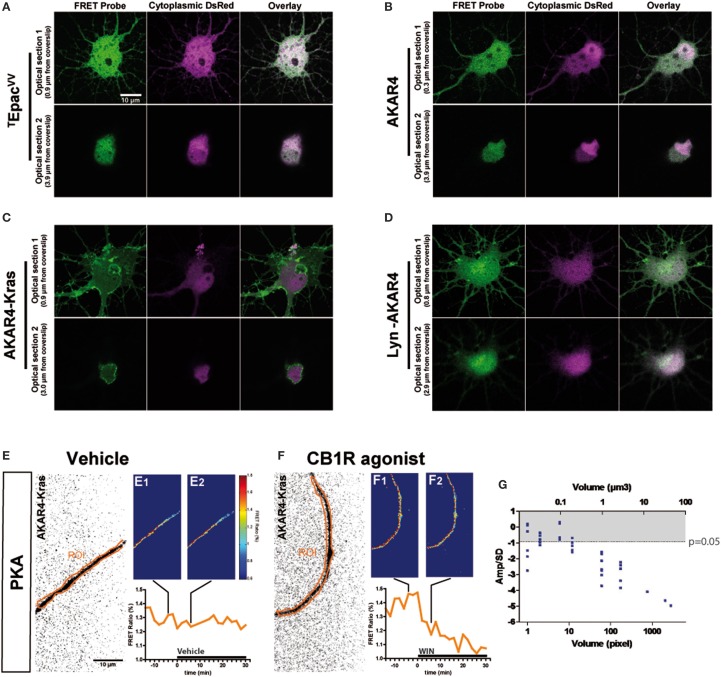
Quantitative measure of basal cAMP/PKA pathway modulation downstream of endogenous neuronal CB1Rs in small cytoplasmic volumes. (A–D) Cultured hippocampal neurons expressing soluble (cytoplasmic) DsRed2 and various FRET probes designed to measure cAMP concentration or PKA activity: TEpacVV
(A), AKAR4 (B), AKAR4-Kras (C), LYN-AKAR4 (D). After fixation, confocal imaging at two different optical sections shows sub-cellular localization of the probes. AKAR4-Kras probes are well-localized to the plasma membrane in the somatodendritic region. (E,F) Modulation of basal PKA activity downstream of endogenous CB1Rs in axonal Regions of Interest (ROI) in AKAR4-Kras expressing neurons. The first image of the acquisition on YFP channel, inverted and with enhanced contrast for better visibility, is shown with the ROI (orange) (E,F). The mean FRET ratio is shown at 4 min (-t4) before (E1,F1) and at 6 min (t6) after (E2,F2) the addition of treatment at t0. Incubation with vehicle does not change the FRET ratio (E2) compared to baseline (E1) but addition of agonist WIN 55-212,2 (WIN) 100 nM induces a rapid FRET-ratio decrease (F2), as compared to baseline (F1). (G) Test of FRET imaging sensitivity by determining the smallest axonal cytoplasmic volume allowing the measurement of significant PKA activity decrease after WIN-induced activation of endogenous CB1Rs. We calculated the mean value of the FRET response amplitude normalized to baseline (Amp) and its standard deviation (SD), in different axonal ROIs, between t4 (4 min after drug treatment) and t14. The ratio of the FRET response amplitude to its standard deviation (Amp/SD) is represented in function of the volume (see text). The WIN effect is significantly different from control (modeled as an effect of Amp = 0 with the same standard deviation than the corresponding WIN-stimulated response) at the Amp/SD ratio equal to −0.91 (in gray, p < 0.05, Student's t-test, N = 10), which is reached starting from ~1 μm3 axonal volume. Data information: Scale bar: 10 μm (A–F).